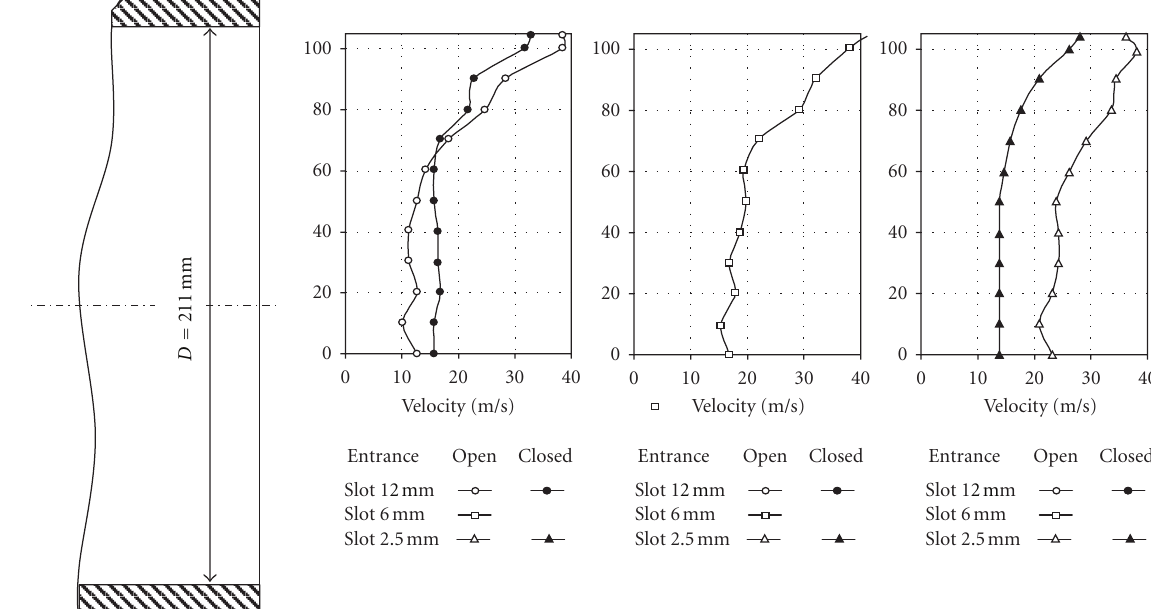
Figure 13: Distribution of mean velocity at the outlet of the reactor model.